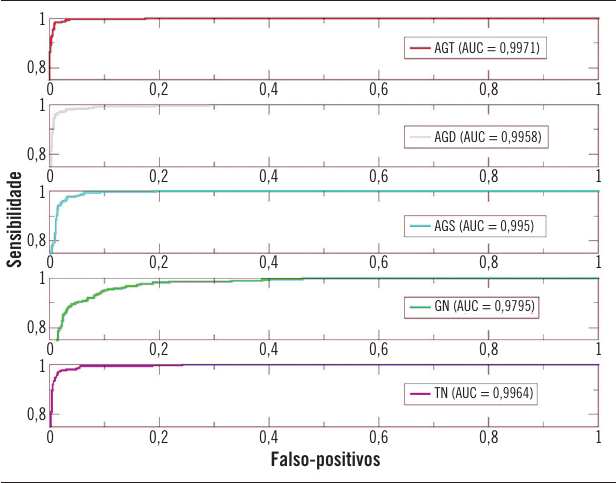
figura 4 – Curvas ROC para as cinco classes definidas e suas respectivas AUC ROC: receiver operator curve ; AUC: área sob a curva ROC; AGT: epitélio gástrico neoplásico/ adenocarcinoma gástrico tubular; AGD: adenocarcinoma gástrico de tipo descoeso/difuso; AGS: adenocarcinoma gástrico de tipo sólido; GN: epitélio gástrico normal; TN: tecidos normais não epiteliais.